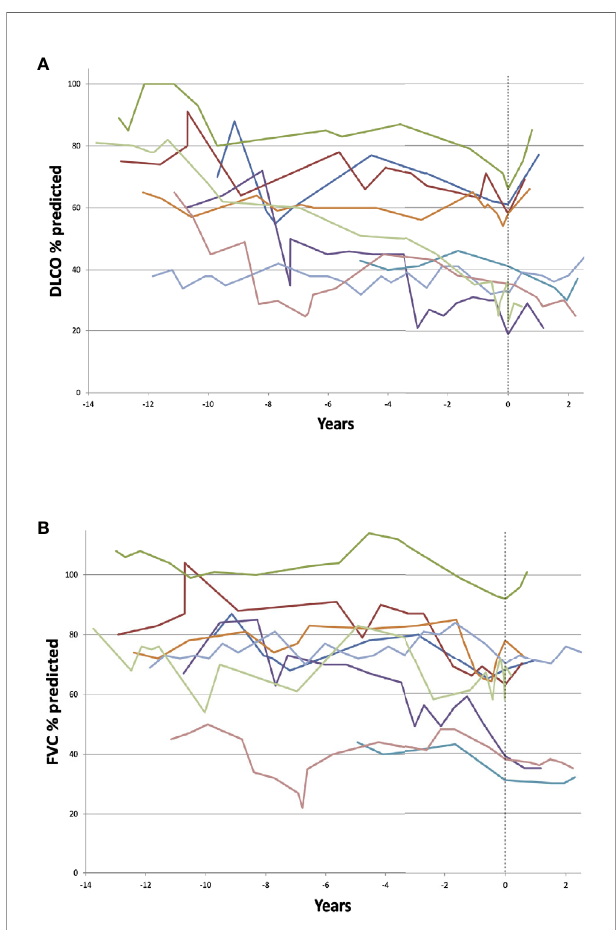
FIGURE 5 | Timeline of diffusion capacity of carbon monoxide (DLCO) (A) and FVC (B) in nine individual granulomatous-lymphocytic interstitial lung disease (GLILD)-patients treated with rituximab. Dotted line represents time of fi rst rituximab treatment. There was no signi fi cant change after treatment in % predicted DLCO or forced vital capacity (FVC). The four patients with a more preserved pre-treatment DLCO with (> 55% of predicted) had a higher annual rate of increase in percent predicted DLCO after treatment than the rest